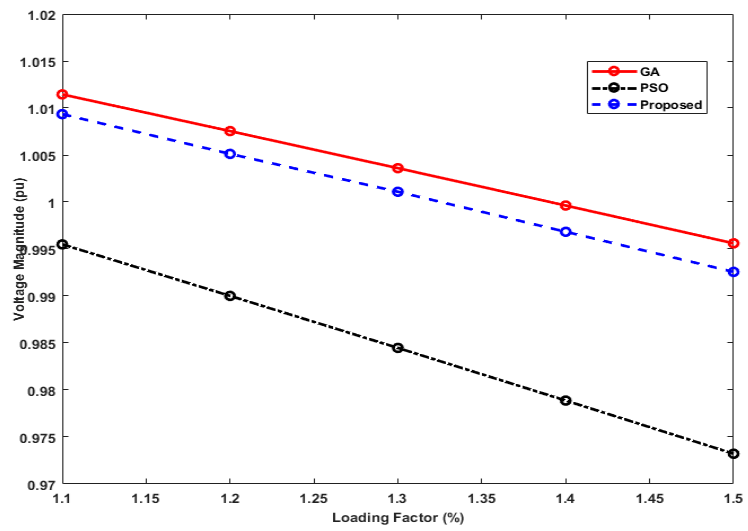
Figure 8. Voltage magnitude of bus 26 versus loading factor.